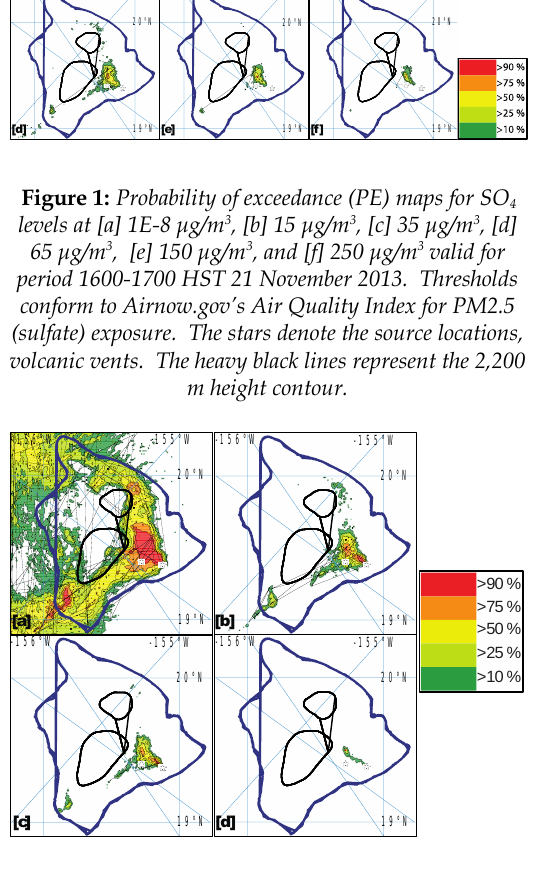
Figure 2: Probability of exceedance (PE) maps for SO 2 levels at [a] 1E-6 PPM, [b] 0.1 PPM, [c] 0.2 PPM, and [d] 1.0 PPM valid for period 1600-1700 HST 21 Novem- ber 2013. Thresholds conform to Hawai’I Department of Health guidelines for sulfur dioxide exposure. SO 2 maps do not exist for higher concentrations because sulfur di- oxide oxidizes rapidly in moist environments to form sulfates (SO 4 ). The stars denote the source locations, vol- canic vents. The heavy black lines represent the 2,200 m height